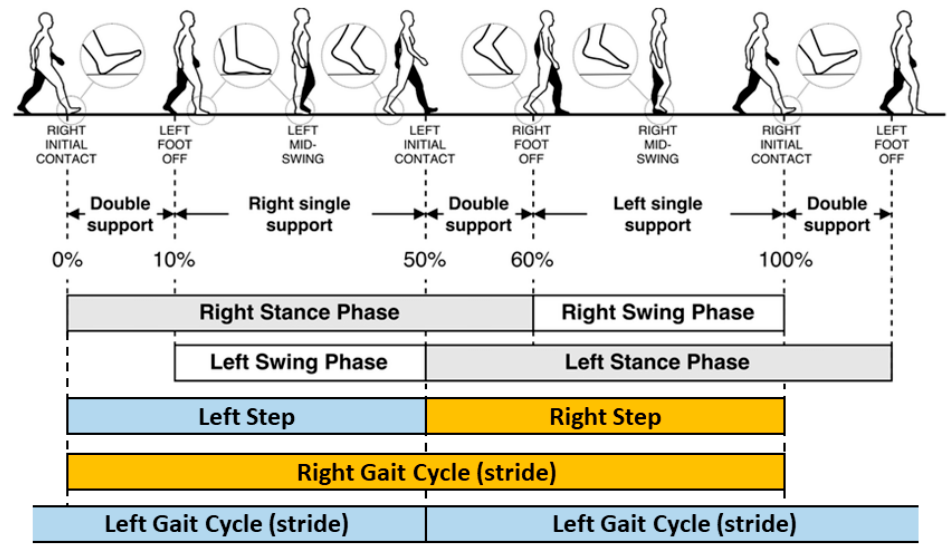
Figure 4. Schematic of the human gait cycle and a selection of the temporal gait characteristics measured in this study. Reproduced and modified with permission from Tunca, C.; Pehlivan, N.; Ak, N.; Arnrich, B.; Salur, G.; Ersoy, C. Inertial Sensor-Based Robust Gait Analysis in Non-Hospital Settings for Neurological Disorders. Sensors 2017 , 17 , 825.